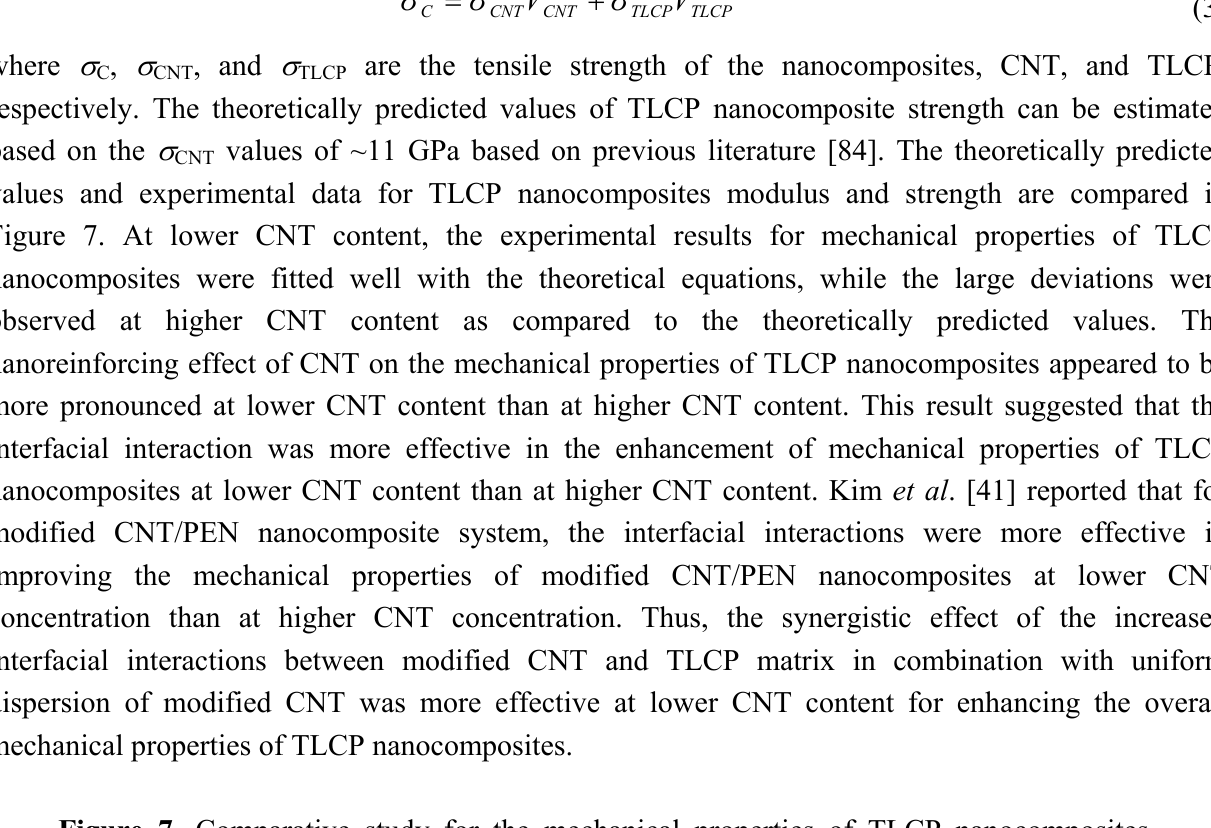
Figure 7. Comparative study for the mechanical properties of TLCP nanocomposites. Theoretically predicted values and the experimental results for (a) the nanocomposite ) and (b) the nanocomposite strength ( σ ) of TLCP nanocomposites. Dotted modulus ( E C C lines represent the theoretically predicted values based on the Equations (2) and